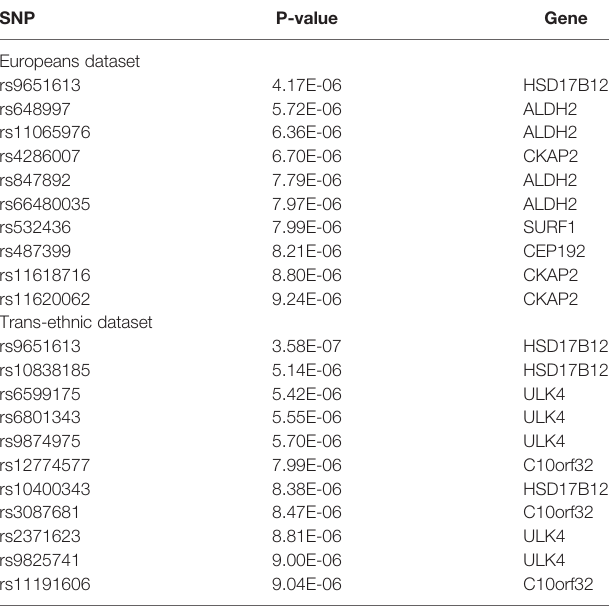
TABLE 2 | SMR results of ischemic